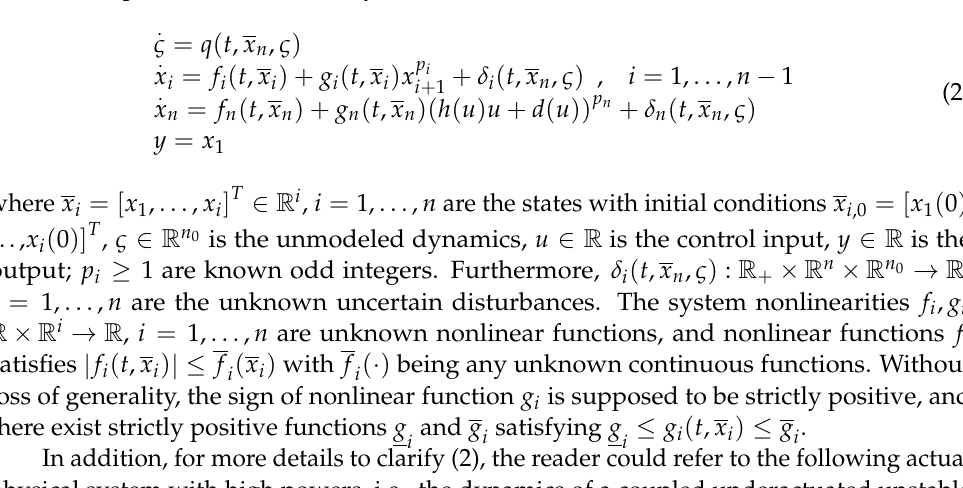
Figure 1. A typical example of thinking about dead zone classes. The following uncertain high-order nonlinear time varying system with dead zone nonlinear input and unmodeled dynamics can be established as